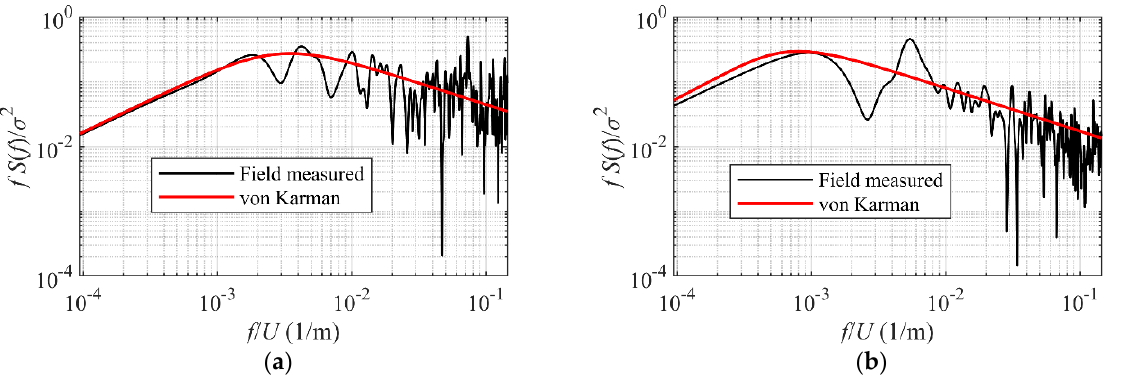
Figure 8. Power spectral density of fluctuating wind speed: ( a ) longitudinal direction; ( b ) lateral direction.